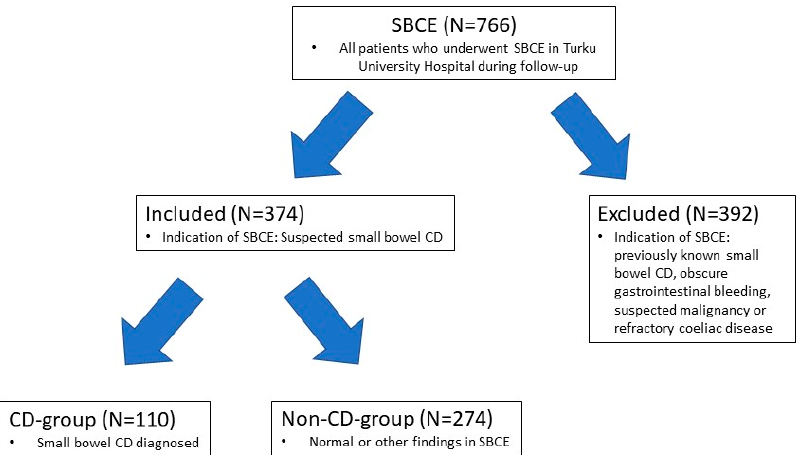
Figure 1. Flow-chart of study design. A retrospective study was conducted for all patients who underwent SBCE (small bowel capsule endoscopy) in the Turku University Hospital between 5 January 2012 and 22 October 2020. Patients whose indication for SBCE was suspected small bowel CD (Crohn (cid:48) s disease) were included and patients with other indications for SBCE were excluded. Included patients were divided in two groups based on whether small bowel CD was diagnosed or not. Patient history with laboratory, endoscopic and imaging findings was collected for included patients and